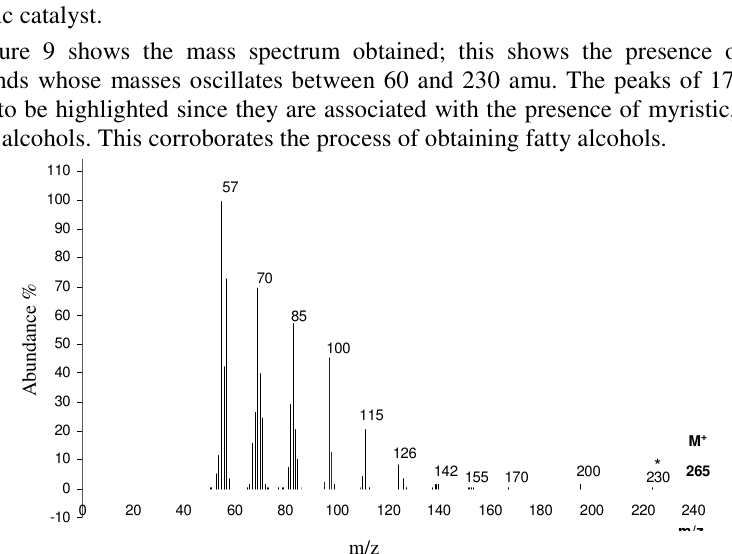
Figure 9 . Mass spectrum of palm oil hydrogenation